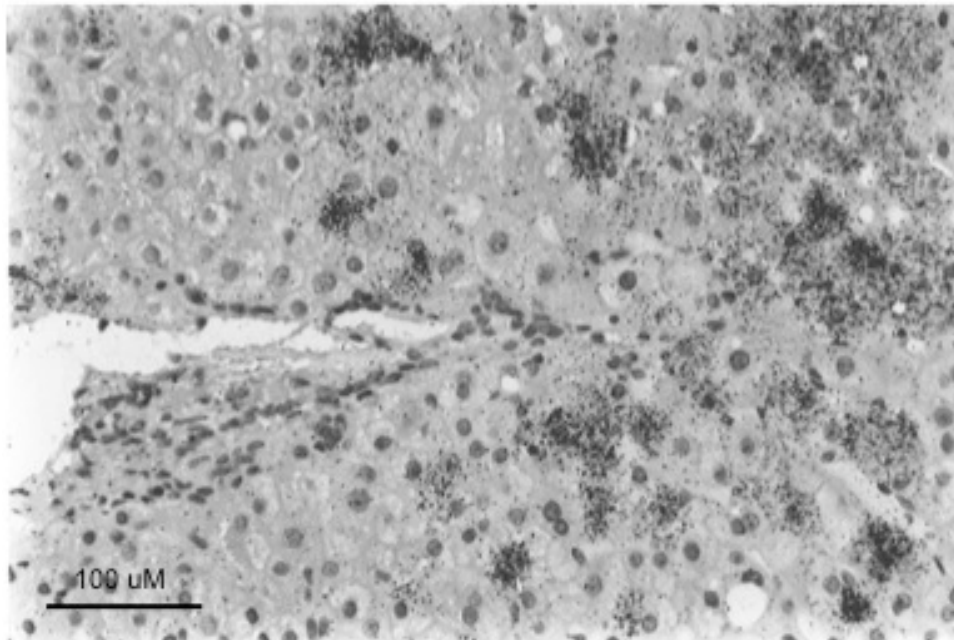
Figure 5. In situ hybridization detection of cytoplasmic HBV DNA, a marker of productive HBV infection in a patient with mild hepatitis and developing cirrhosis. Hepatocytes containing high-levels of HBV DNA were distributed randomly and in periportal regions of the lobule. Many hepatocytes with undetectable levels of HBV DNA were also observed. HBV DNA was detected by in situ hybridization with an 125 I-labelled HBV DNA probe followed by autoradiography for 168 h and staining with hematoxylin and eosin (H&E). Figure adapted and reproduced with permission from reference [95], Mason et al., Hepatology International, published by Springer, 2007.